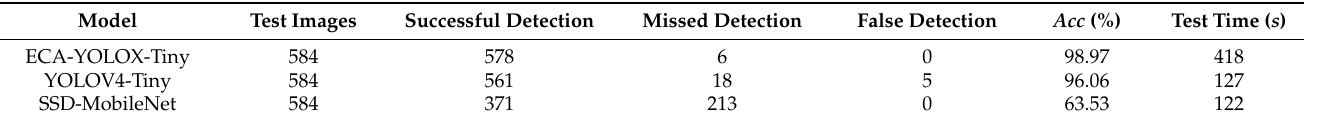
Table 7. The detection results of different models on the test set.